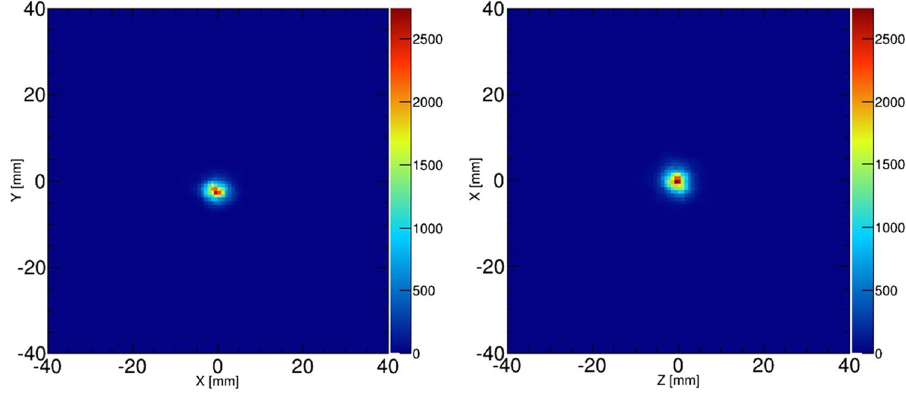
Figure 1. 2-D slices of the 22 Na point source image in the X-Y plane ( left ) and Z-X plane ( right